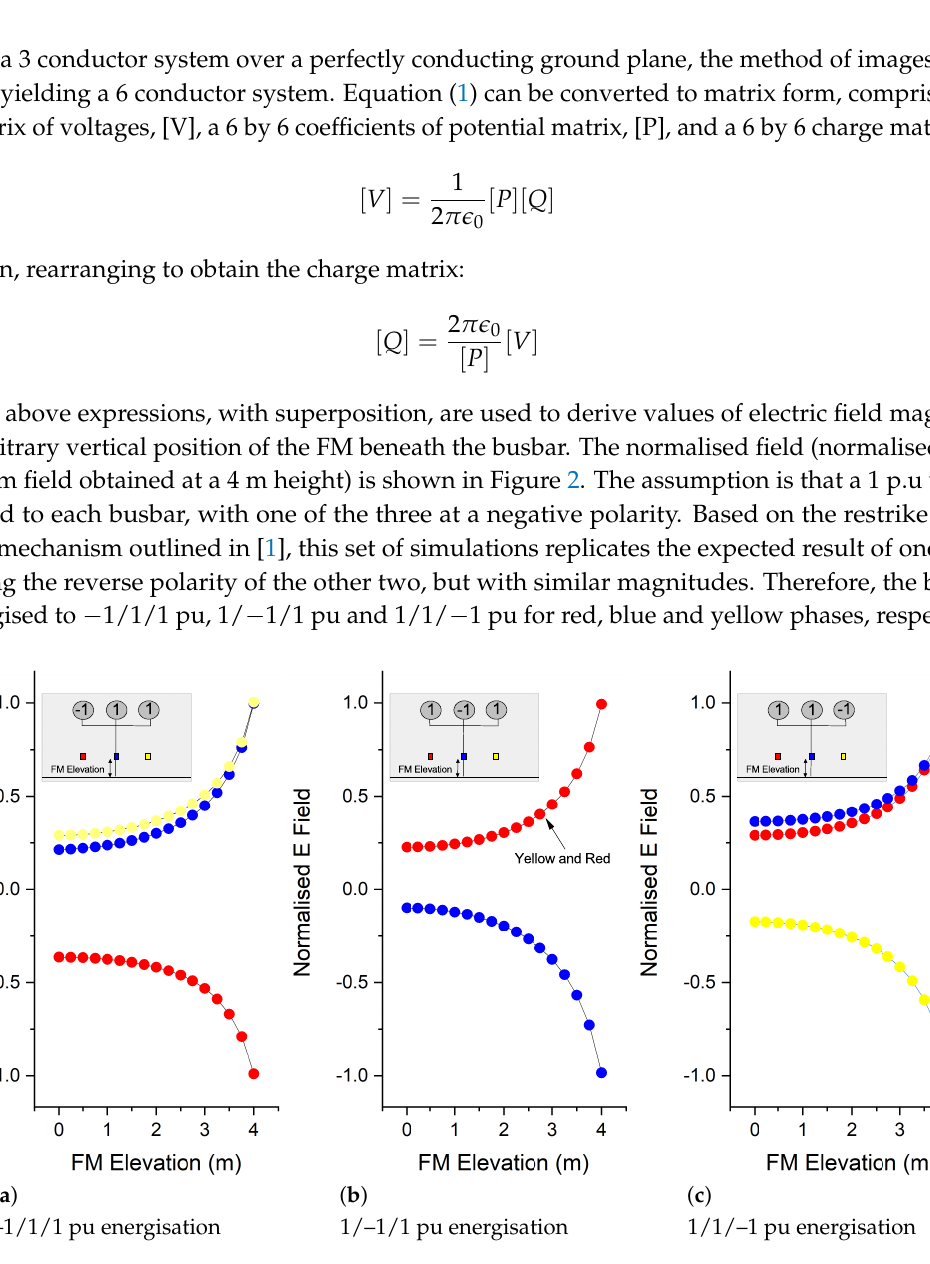
Figure 2. Simulation results showing the normalised electric field magnitude at each FM as a function of elevation for energisation of each busbar of ± 1 pu. The polarity of each busbar is signified in the top left of each plot area (note that the diagram is not to scale). The fixed height of the busbars above ground is 4 m and the separation is 6